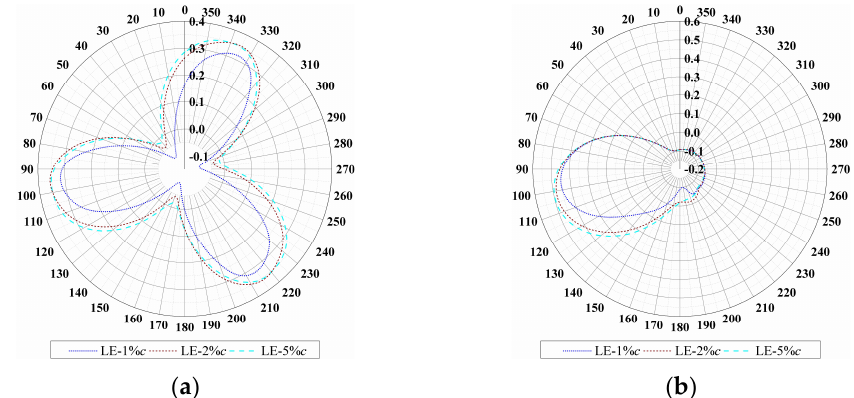
Figure 9. Variation of C m with respect to θ during one rotational period at TSR = 2.0 for ( a ) the rotor; ( b ) blade 1.